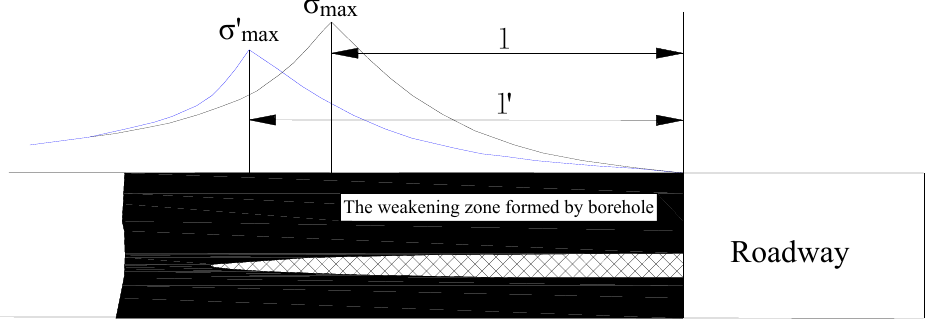
in the roadway sidewalls before and after pressure relief. The symbols l and l’ are the distances from